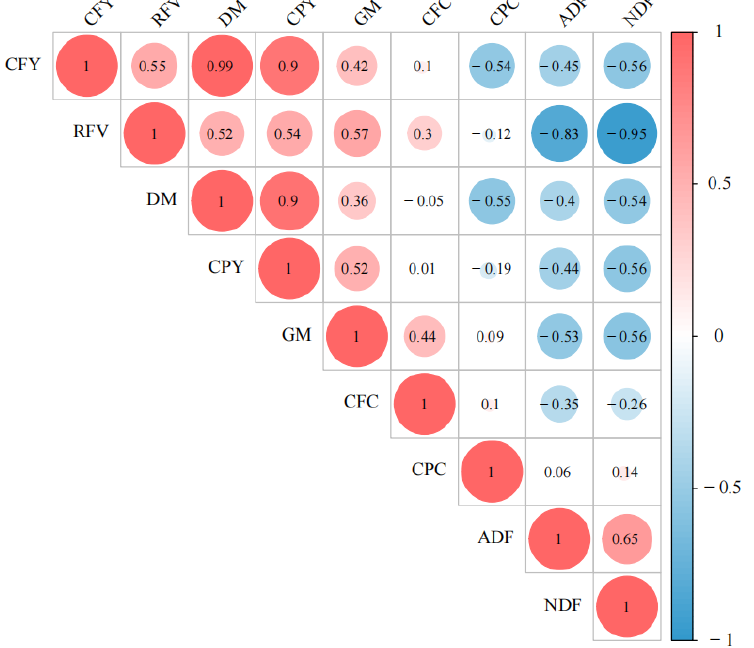
Figure 5. The relationship between forage quality and biomass. Green biomass (GM), Dry matter (DM), Crude protein content (CPC), Crude protein yield (CPY), Crude fat content (CFC), Crude fat yield (CFY), Acid detergent fibre (ADF), Neutral detergent fibre (NDF), Relative feed value (RFV).